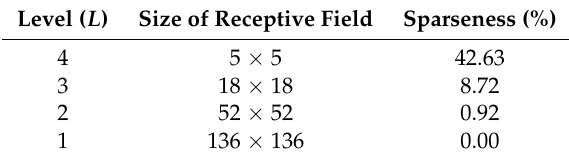
Table A2. Size of Receptive Field and Sparseness at Each Level of